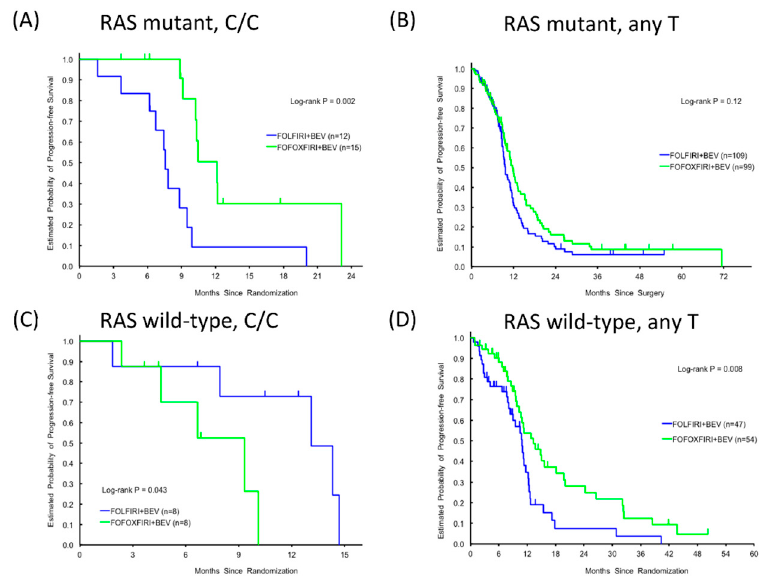
Figure 2. Progression-free survival (PFS) according to RPA2 rs7356 variants, C / C or any T in the discovery cohort ( — ) and the control cohort ( — ): C / C, RAS mutant ( A ), Any T, RAS mutant ( B ), C / C, RAS wild-type ( C ), Any T, RAS wild-type ( D ).